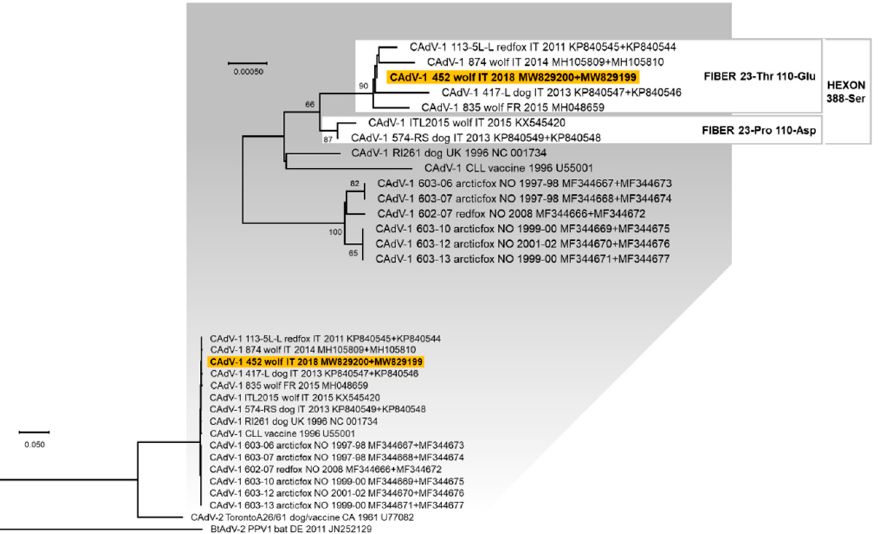
Figure 2. Rooted phylogenetic tree constructed with the multiple gene approach (concatenated nucleotide sequences of the hexon and fiber genes) of canine adenovirus (CAdV) obtained in this study and reference strains in the GenBank database (Table S2). Phylogeny was carried out using the Maximum Likelihood method and Hasegawa–Kishino–Yano (HKY) model with invariable sites. The robustness of the individual nodes on the phylogenetic tree was estimated using 1000 bootstrap replicates. Bootstrap values greater than 60% are indicated. The scale bars indicate the estimated numbers of nucleotide substitutions. On the top of the figure, a portion of the obtained tree is enlarged to better visualise the phylogenetic relationships existing between the CAdV-1 nucleotide sequences and the bootstrap values. For some viruses two GenBank accession numbers are reported (the hexon and fiber genes sequences, respectively). Highlighted in yellow: nucleotide sequence generated in this study. The amino acid residues in position 388 for the deduced hexon protein and in positions 23 and 110 for the deduced fiber protein are reported.